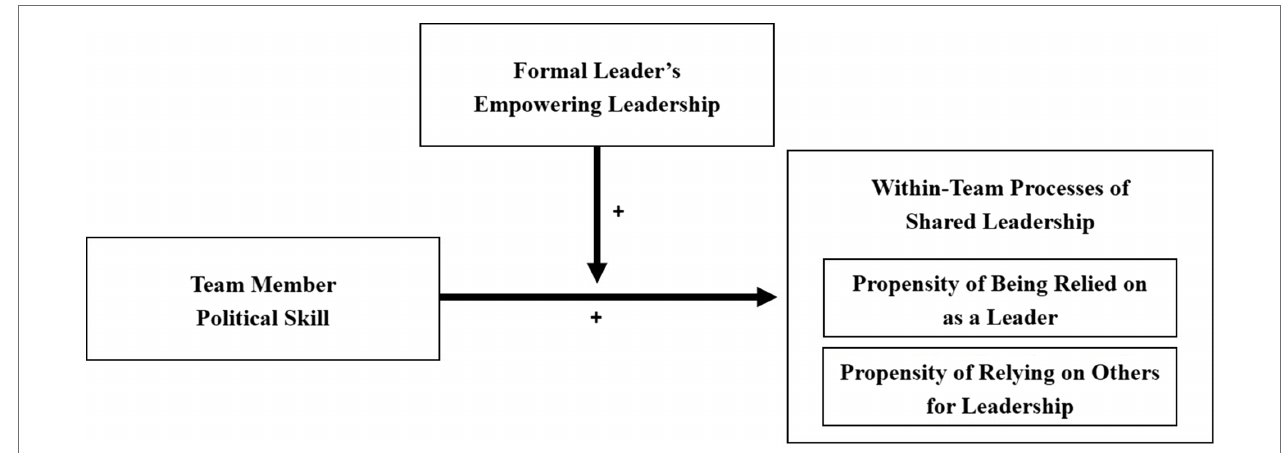
FIGURE 1 | Theoretical model of the moderated influence of political skill on shared